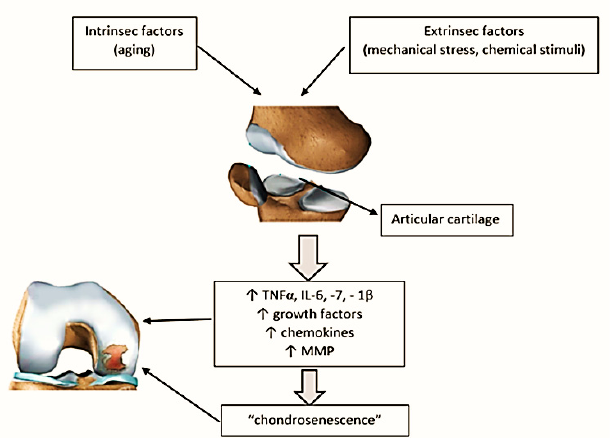
Figure 5. Mechanisms of osteoarthritis in aging. The incidence of osteoarthritis increases proportionally with age, but it cannot be considered a direct consequence of aging. The term “chondrosenescence” refers to all “age-dependent deterioration of chondrocytes as a consequence of replicative (intrinsic) and stress-induced (extrinsic) factors”. Intrinsic factors refer to the aging process, while extrinsic factors include physical-mechanical factors or different chemical stimuli. All these factors act on articular cartilage, making it vulnerable. As a consequence, an inflammatory environment characterized by increased proinflammatory cytokines (TNF α , IL-6,-7,-1 β ), chemokine, and activated proteinase occurs locally. All these lead to the aging process of chondrocytes (chondrosenescence), which favors the appearance of degenerative joint modifications.